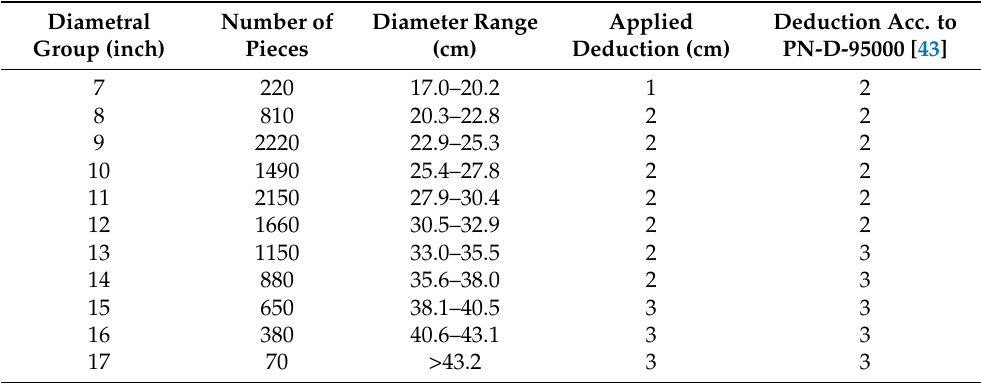
Table 1. Diametral groups and the applied bark